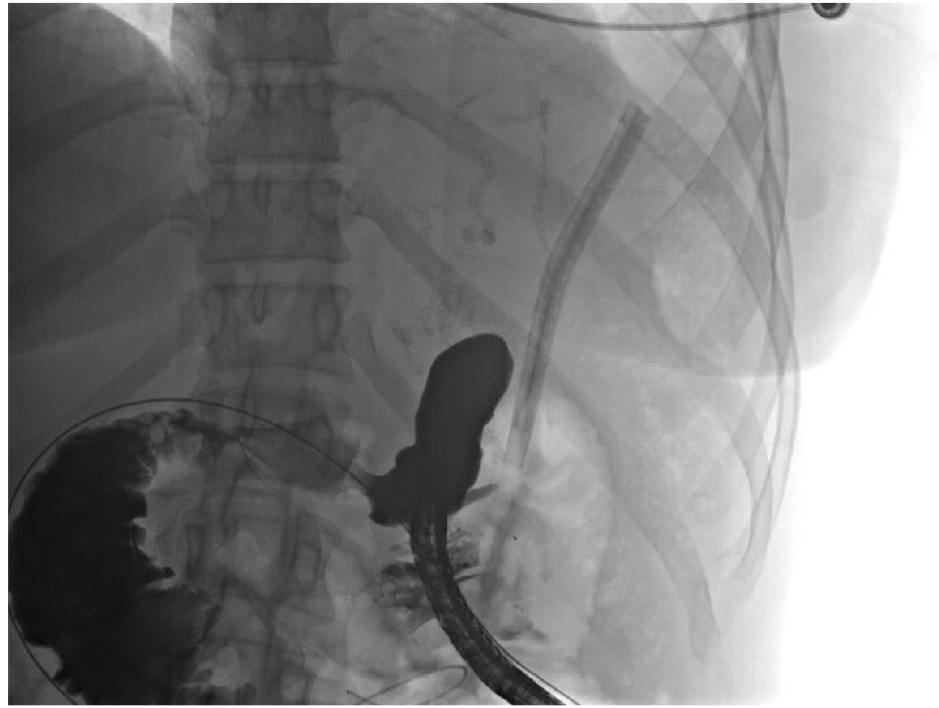
Figure 6. Endoscopic access to remnant stomach via mature gastrostomy site.